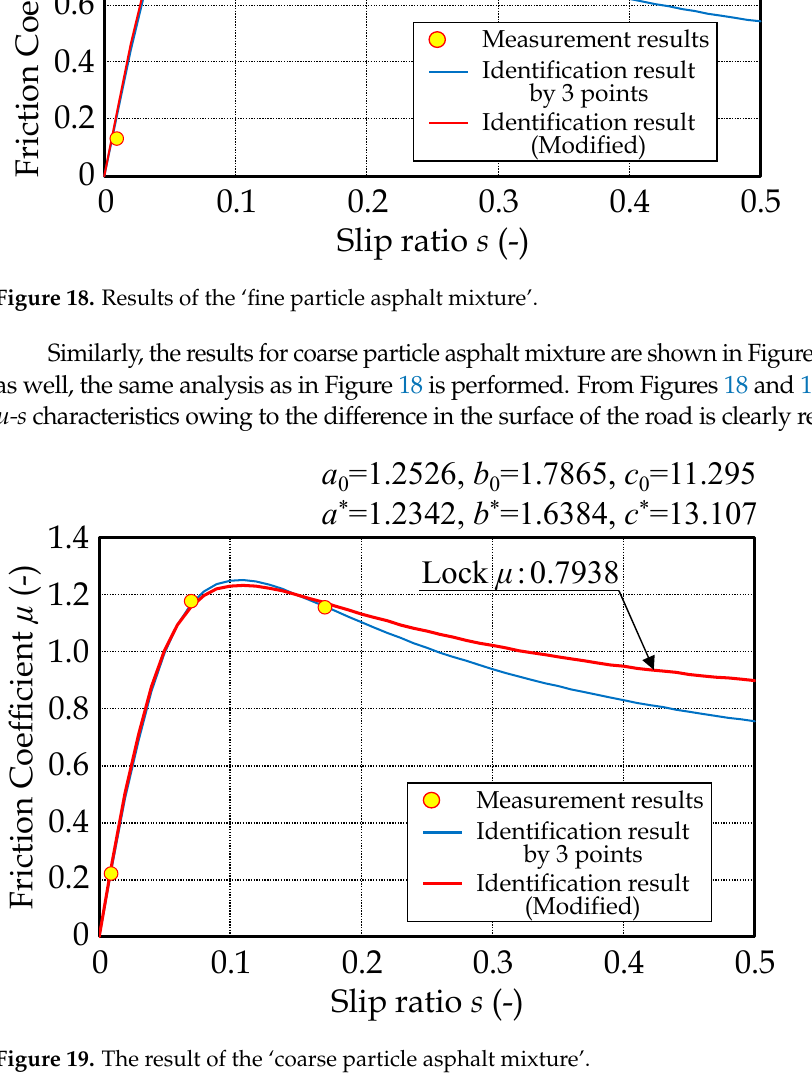
Figure 19. The result of the ‘coarse particle asphalt mixture’. Next, it is necessary to compare these differences with the tire characteristics measured by the bench tester and confirm the validity of the results measured by this device. These results are shown in Figure 20 to confirm the characteristic difference due to the difference in the road surface for the same tires in the same setting conditions. These need to be considered separately in three regions. The first is the characteristic of rising with strong linearity, which is the region for confirming the above-mentioned K B